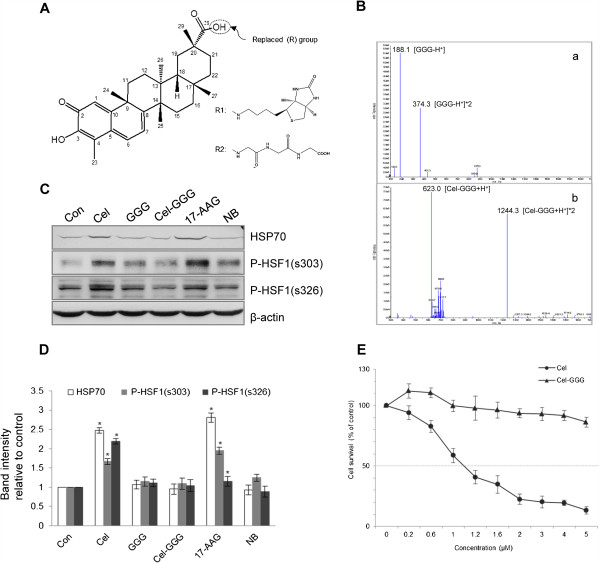
The effects of celastrol carboxyl group modification on HSP70 induction. (A) Structure of celastrol and its modifications. The circled point indicates the modification location. R1 represents one of the structures that used by Klaić et al. to create celastrol analogues, while R2 is tri-peptide of glycine, the analogue used in this paper. (B) Identifications of (a) tri-peptide of glycine and (b) the celastrol analogue were `performed by mass spectrum analysis. (C) Effects of the celastrol analogue on HSP70 expression and HSF1 phosphorylation. U937 cells were treated with 600 nM of celastrol, GGG, Cel-GGG, 17-AAG, or NB for 24 h. For phosphorylation assay, cells were incubated with drugs for 10 min. WB detected HSP70 and p-HSF1 (s303 and s326). (D) The histogram shows western blot band density statistics for part C. * represents P < 0.05 vs. control. (E) Effect of the celastrol analogue on proliferation inhibition. Cells were treated with 600 nM of celastrol or its analogue for 24 h, and cellular survival was analyzed by FCM according to our previous report. GGG: tri-peptide of glycine; Cel-GGG: celastrol joined with tri-peptide of glycine through peptide formation.